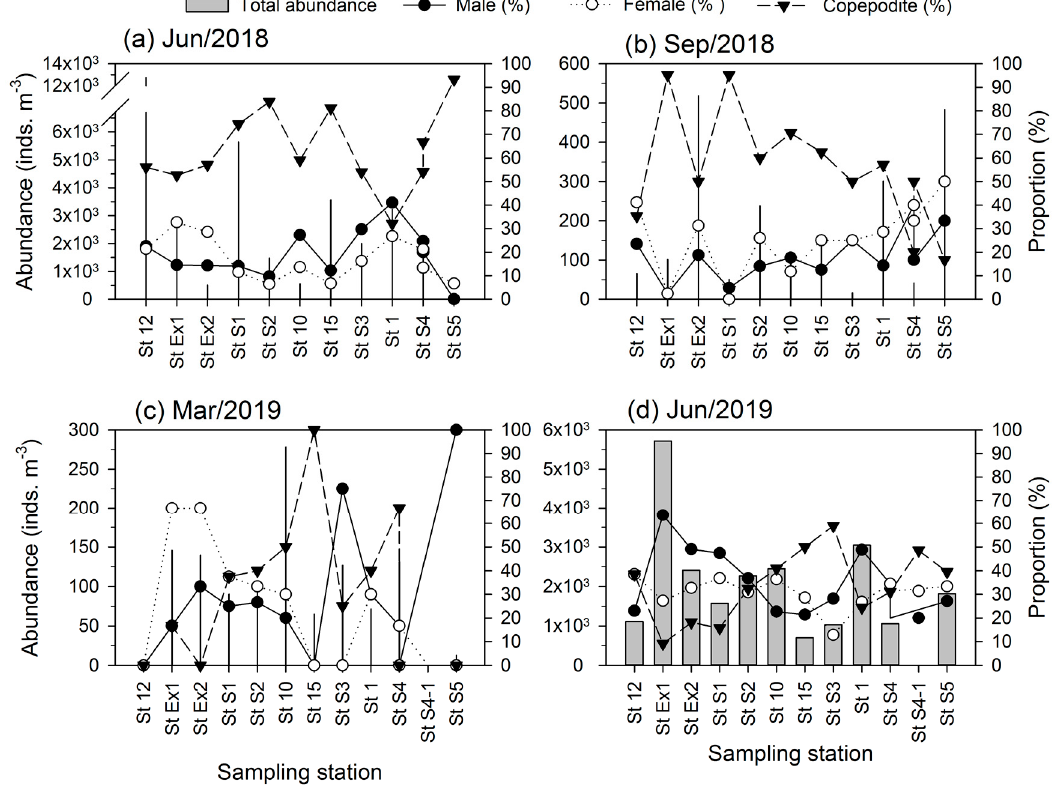
Figure 3. The variation of abundance and composition of Temora turbinata population during each cruise; variation in June ( a ), September ( b ) 2018; and March ( c ), June ( d ) 2019.